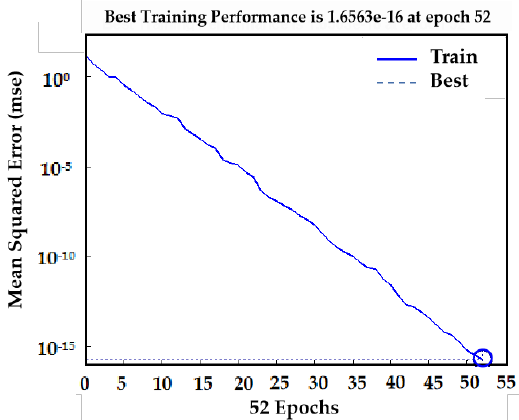
Figure 18. Multiparameter neural network training performance. Table 15. Multiparameter neural network prediction results.